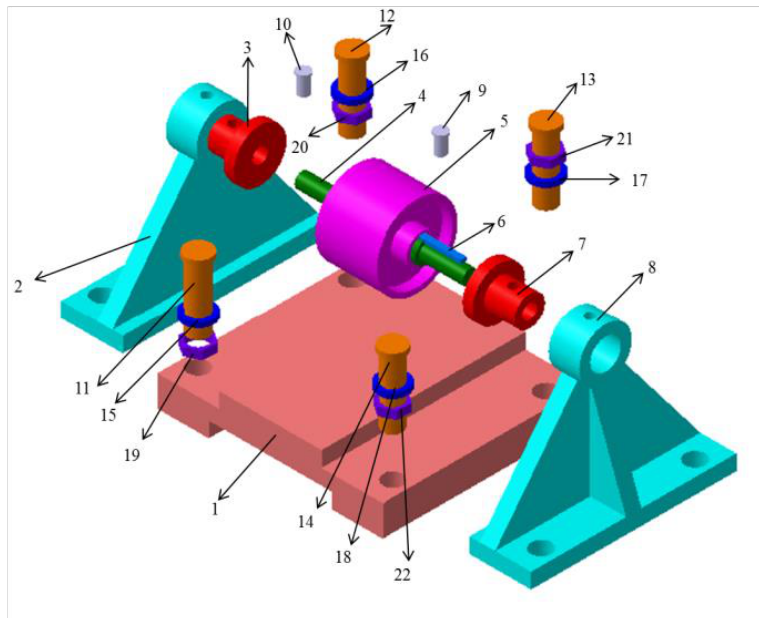
Figure 5. Represents the pulley assembly for clash analysis